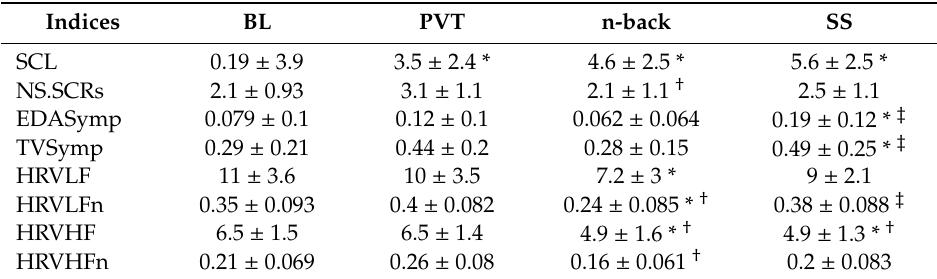
Table 1. Indices of HRV and EDA during baseline, PVT, n-back, and ship search (SS) tasks. Indices